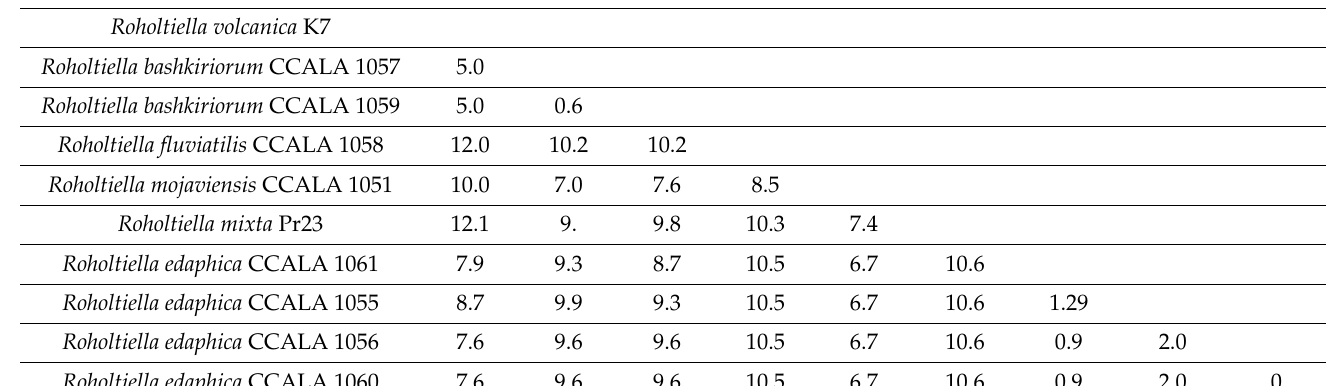
Description: Thallus flat, in the form of upright tufts with visible filaments on the substrate, blue-green, olive-green, or brown-green. Filaments short to long, single or rarely false branched, heteropolar. Sheath thick, firm, clearly delimited, in old cultures widened, distinctly layered, closed at the ends or becoming diffluent towards the ends, colorless. Trichomes constricted at crosswalls, not tapered or distinctly gradually tapered, slightly or distinctly swollen at the base, 2.9–9.1 µ m wide. Cells shorter than wide, isodiametric or sometimes longer than wide, barrel-shaped, cylindrical, to almost spherical or spherical compressed, with smooth to finely granulated content, olive-green, brown, purplish-grey, or blue-green, 3.1–10.6 long. End cells conical, conical rounded, or rounded.